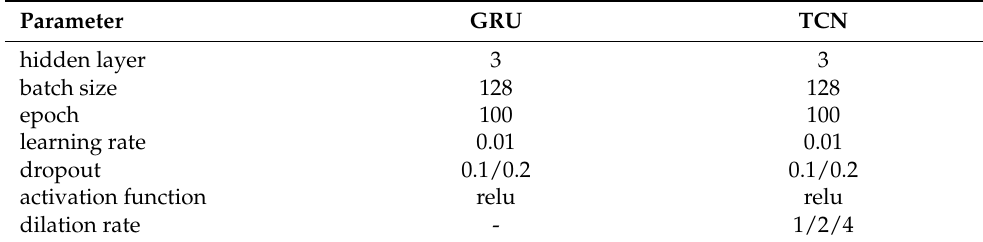
Table 2. Parameters of neural networks.